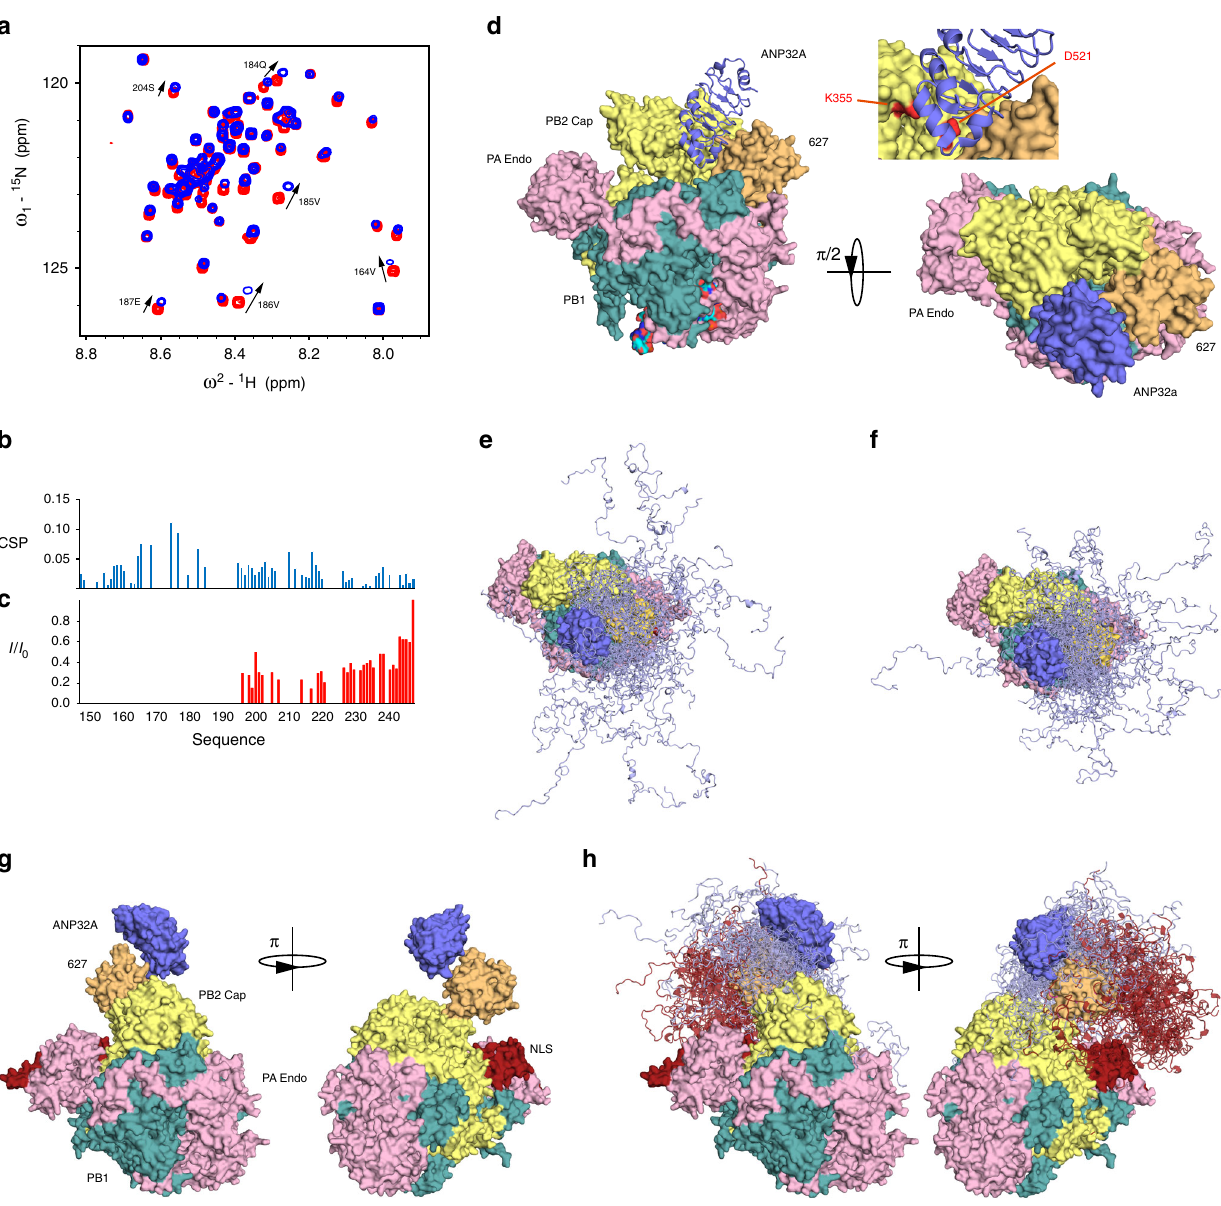
Fig. 6 Interaction of hANP32A with full-length FluB polymerase. a Chemical shifts of 15 N-labelled IDD of h ANP32A (4 μ M) upon addition of full-length FluB polymerase (32 μ M) bound to viral promoter RNA ( v RNA). Measurement at 850 MHz, 293 K. Red — free protein, blue — in presence of polymerase. Notably the distribution of chemical shifts is highly similar to that induced in h ANP32A upon addition of IAV 627-NLS(K). b CSP associated with a . c Intensity ratio of 15 N-labelled full-length h ANP32A (4 μ M) upon addition of full-length FluB polymerase (32 μ M) bound to v RNA. d Compatibility of the experimentally observed binding mode in the context of the vRNA-bound conformation of FluB polymerase 26 . The 627 domain was superimposed on the 627 domain of PB2 in the full-length polymerase structure (4wsa). In this position, ANP32A LRR can be accommodated in a large pocket formed by 627 (yellow – orange), and cap-binding domains of PB2 (yellow) and bordered by PB1 (dark-cyan). Inset: PB2 adaptive mutants D521 and K355 lie in the immediate vicinity of ANP32A LRR. e Conformational sampling of the IDD of h ANP32A, assuming the position of the LRR of ANP32A shown in d . The linker and NLS domains are not shown for clarity and are assumed fl exible. f Conformational sampling of the IDD of av ANP32A (otherwise as in e ). g Compatibility of the experimentally observed binding mode in the context of the cRNA-bound conformation of FluB 29 . The 627 domain was superimposed on the 627 domain of PB2 in the full-length polymerase structure (5epi), which is dislocated relative to the vRNA-bound form. ANP32A LRR can be accommodated easily on the accessible surface of 627. The NLS domain (brick red) is detached from 627 in this structure. h Conformational sampling of the IDD of h ANP32A, assuming the position of the LRR of ANP32A shown in g . Sampling of the IDD (light blue) linker and NLS domains are shown (brick intrinsically very weak, but experimental NMR, including CSP case of h ANP32A:627-NLS(K), involving weak, polyvalent and PREs, accurately report on the relative position of the two interactions of acidic and hydrophobic residues of the IDD. The domains. The disordered domain interacts transiently with a presence of multiple low-af fi nity interactions (in the millimolar basic patch on the surface of the 627 domain, preferentially in the range individually) distributed throughout 80 amino acids of the